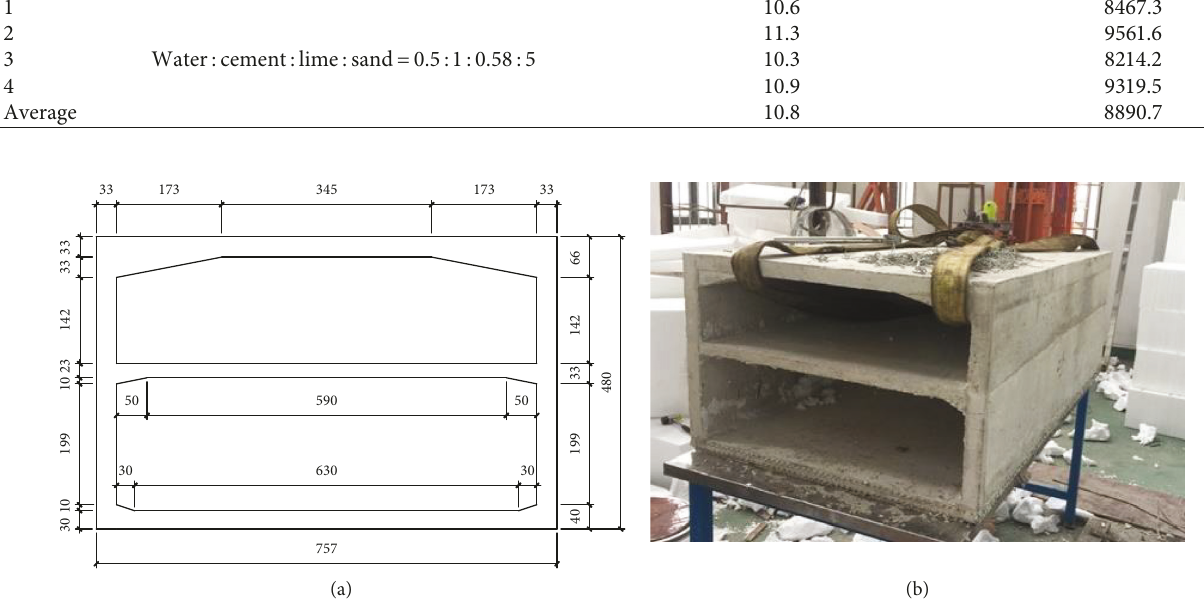
Figure 3: Model structure. (a) Dimensions of the model structure cross section (unit: mm). (b) Physical